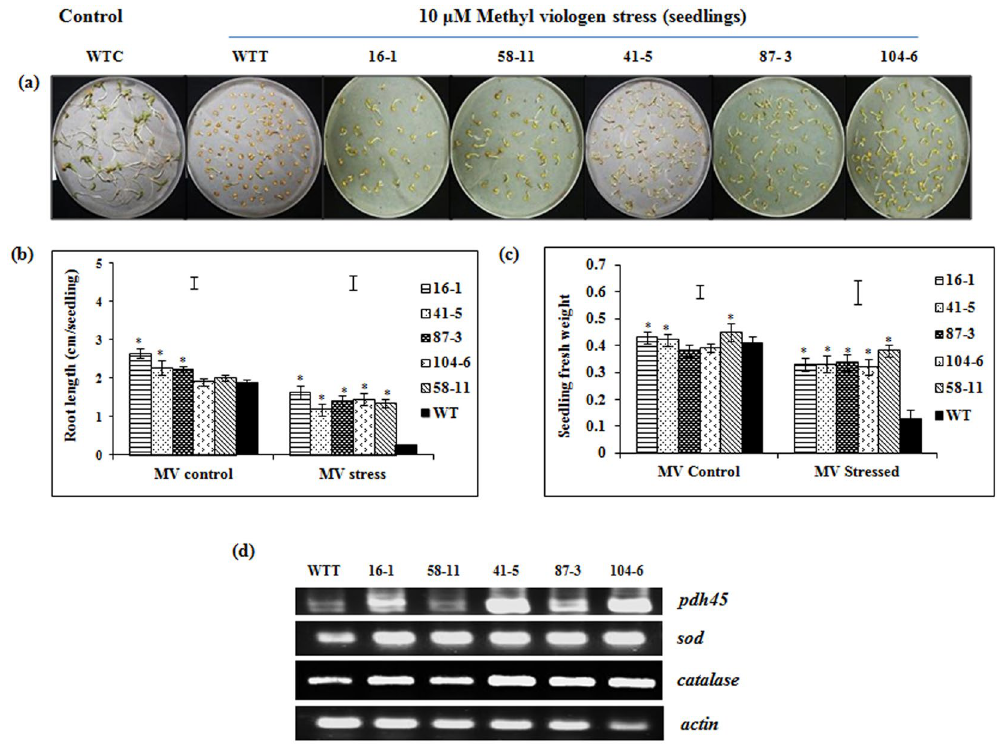
Figure 5. Response of the selected transgenic events to simulated oxidative stress induced by 10 µ M methyl viologen. ( a ) Effect of oxidative stress on the seedlings of transgenic events and WT; ( b ) seedling root length (cm); ( c ) seedling fresh weight (g); ( d ) sqRT-PCR analysis of PDH45 and stress-responsive genes in the stressed seedlings. (WTC = wild type control; WTT = wild type treated. Bars in the graph area indicate LSD value at P < 0.05; ( * ) indicates significant differences at P <